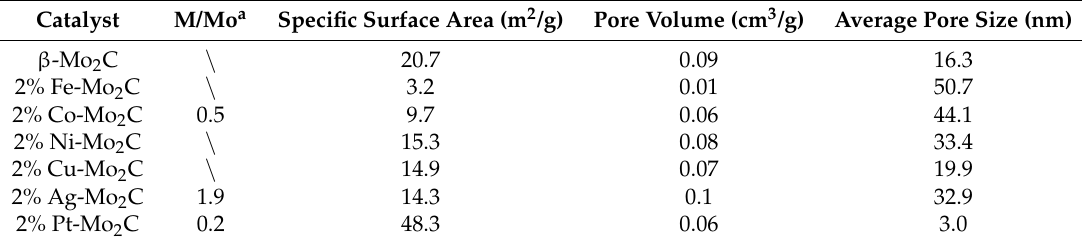
Table 2. Brunner − Emmet − Teller measurements (BET) surface area and inductive coupled plasma (ICP) of various metal doped molybdenum carbides and β -Mo 2 C. Catalyst M/Mo a Specific Surface Area (m 2